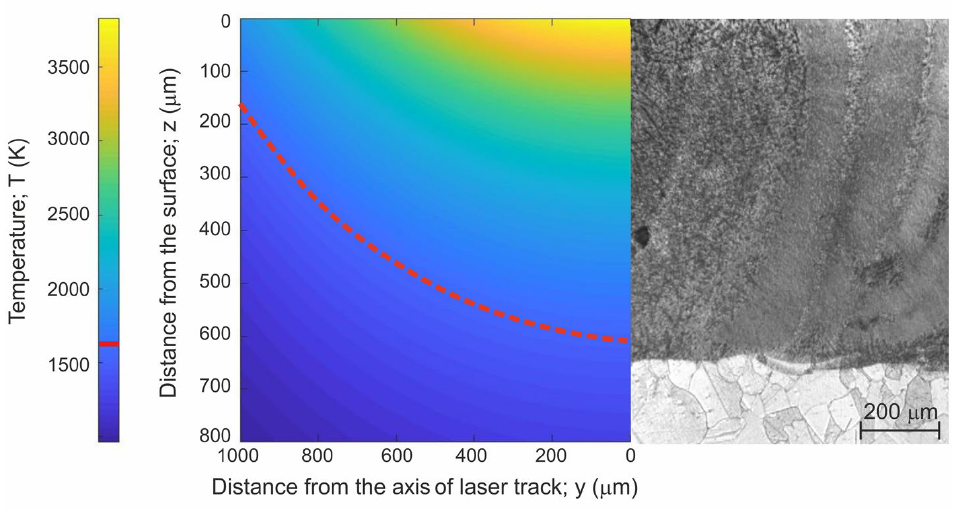
Figure 11. A 2D cross-section of the temperature distribution in the molten pool with marked melting point of Nimonic 80A alloy and the OM microstructure of laser borided layer produced at the laser beam power of 1.95 kW. Table 3. Modeled depths and maximum temperatures compared with experimental thickness of laser borided layers produced on Nimonic 80A